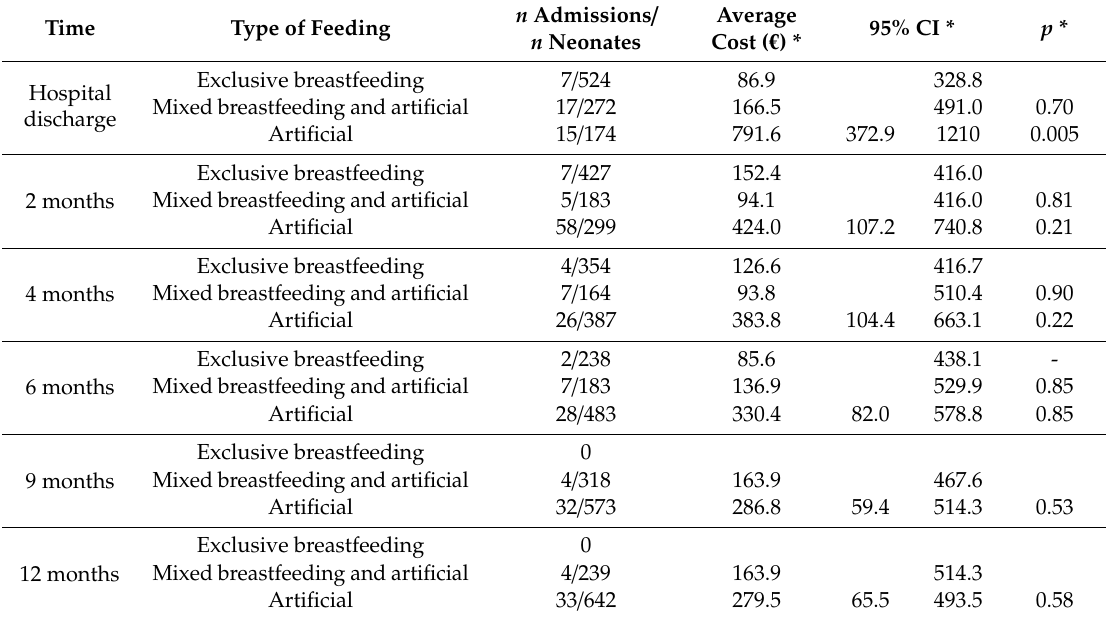
Table 4. Relationship between type of feeding and costs due to admissions for infectious